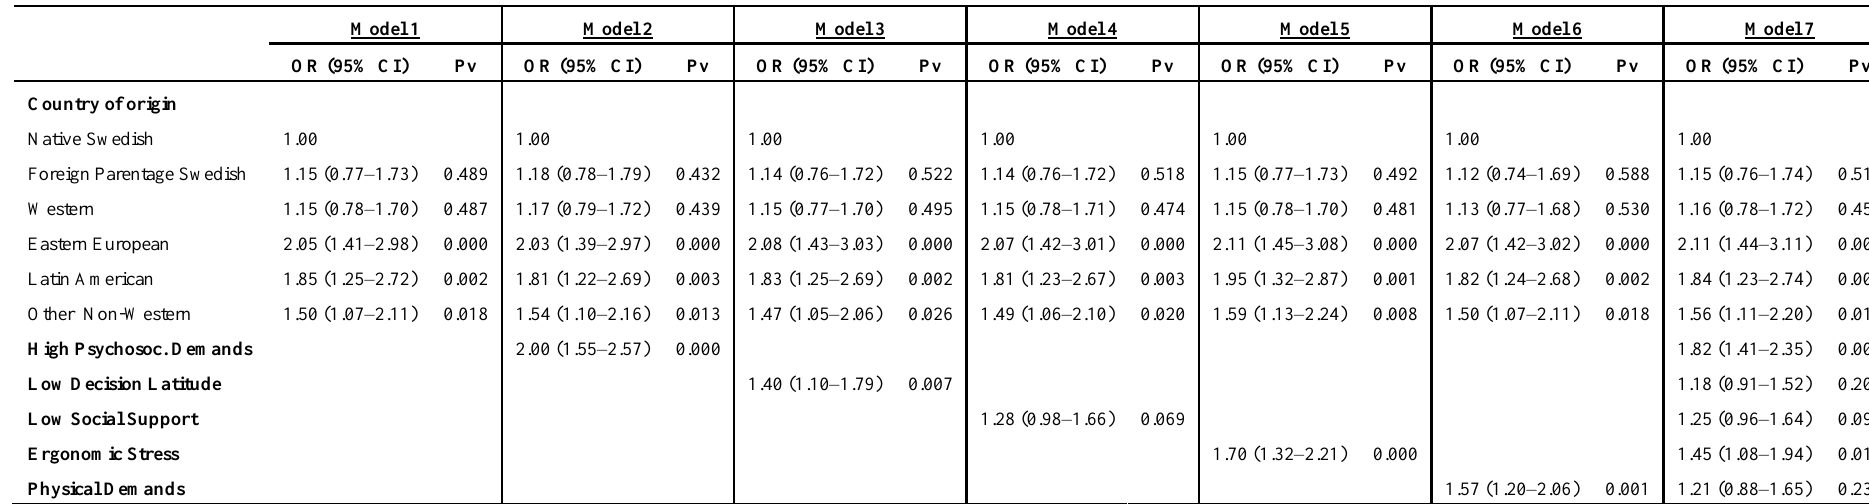
Table 3. Multivariate regression analysis of risk for mental distress among foreign background workers in Sweden